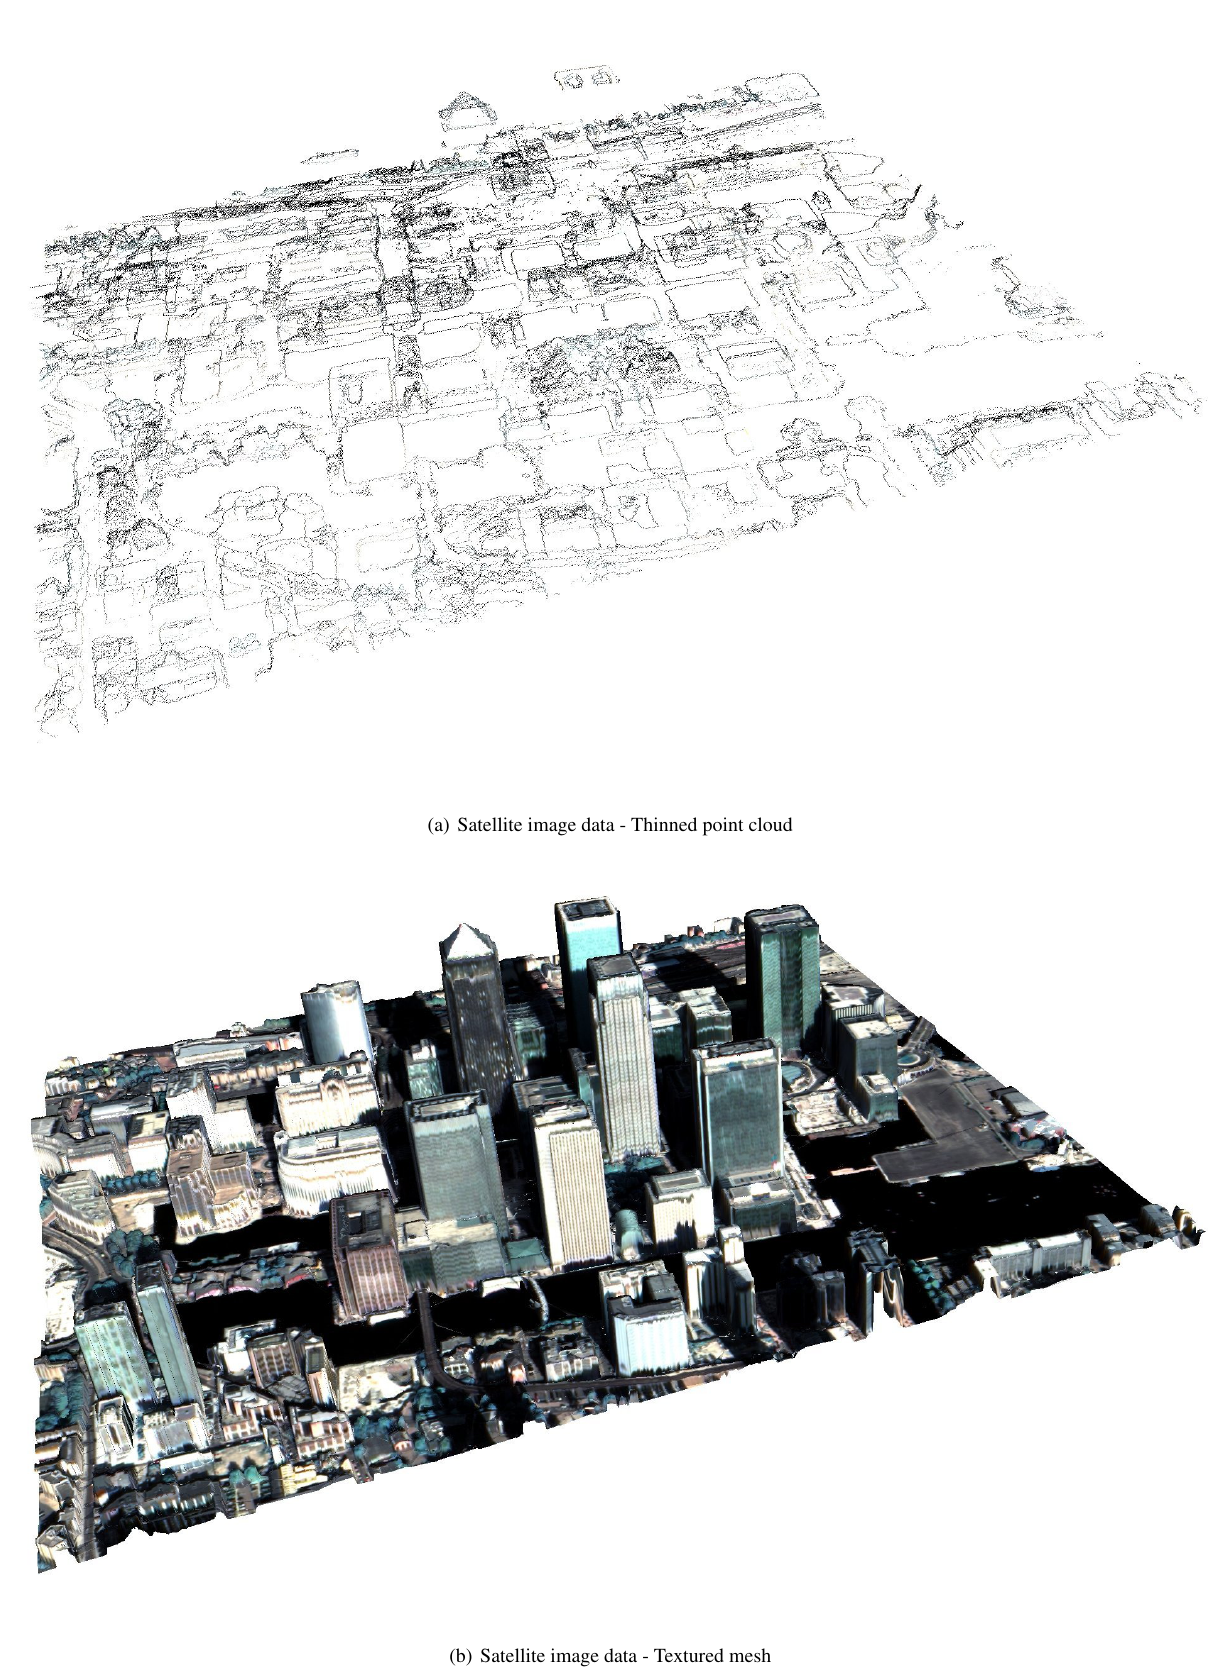
Figure 9: Resulting 3D model of the satellite image